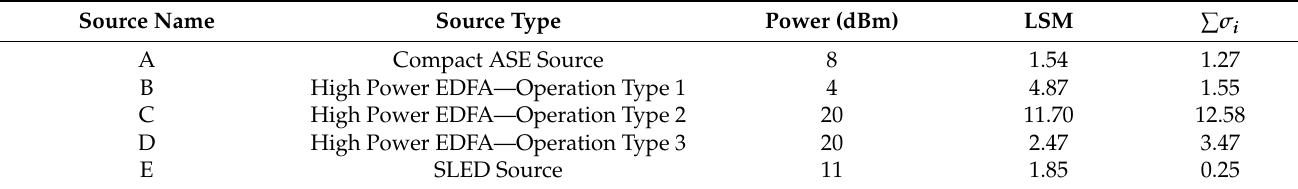
Table 1. Details of the light sources used in the first experiment. The least-square error (LSM) and the sum of the error bar were evaluated as the criterion of